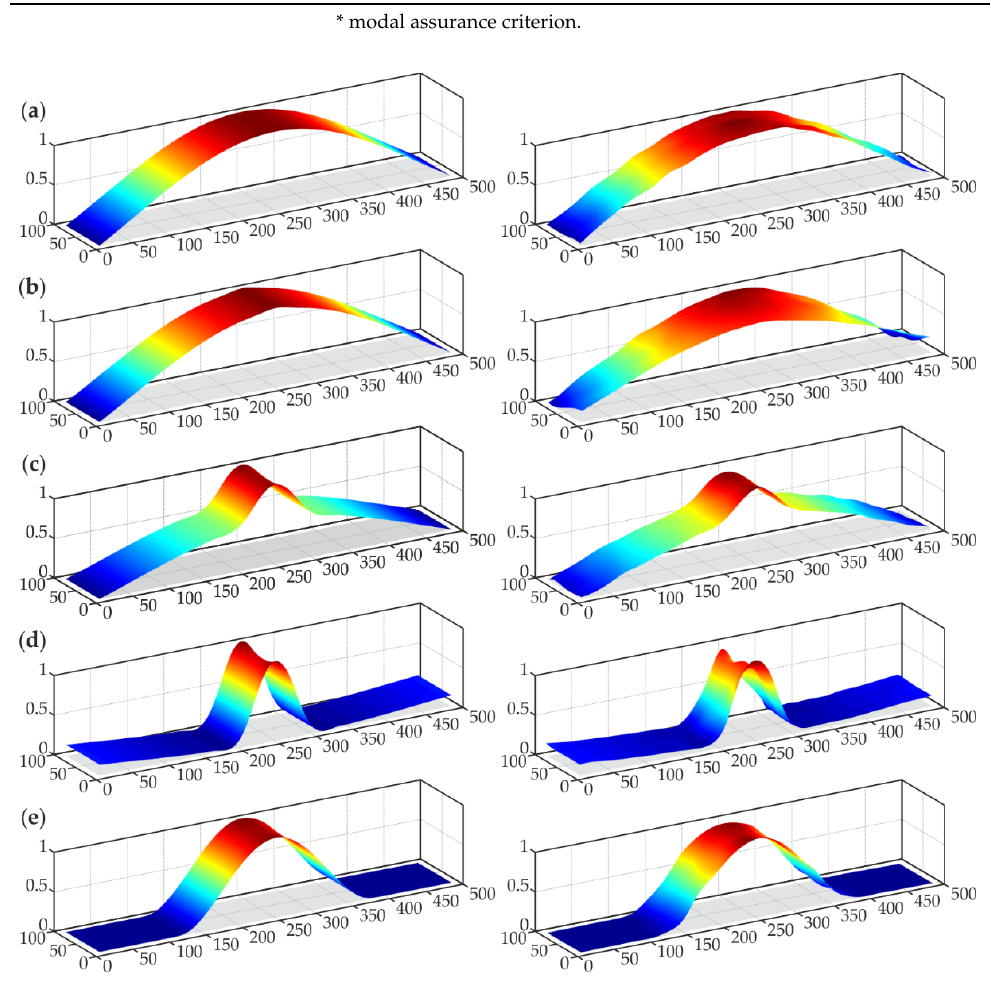
Figure 4. Normalized numerical (left column) and experimental (right column) mode shapes (dimensions in [mm]): ( a ) sample #1, mode 1; ( b ) sample #2, mode 1; ( c ) sample #3, mode 1; ( d ) sample #3, mode 2; ( e ) sample #4, mode 1.